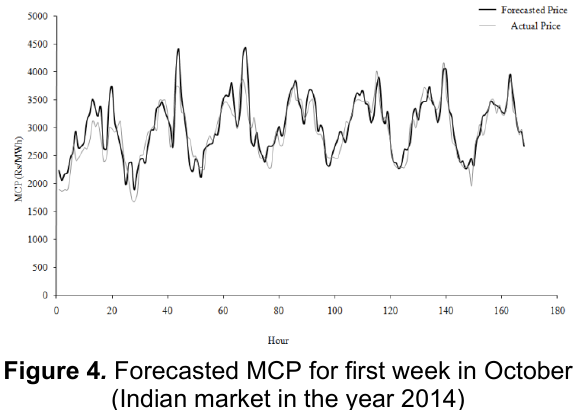
Figure 6 . Forecasted MCP for a week in June